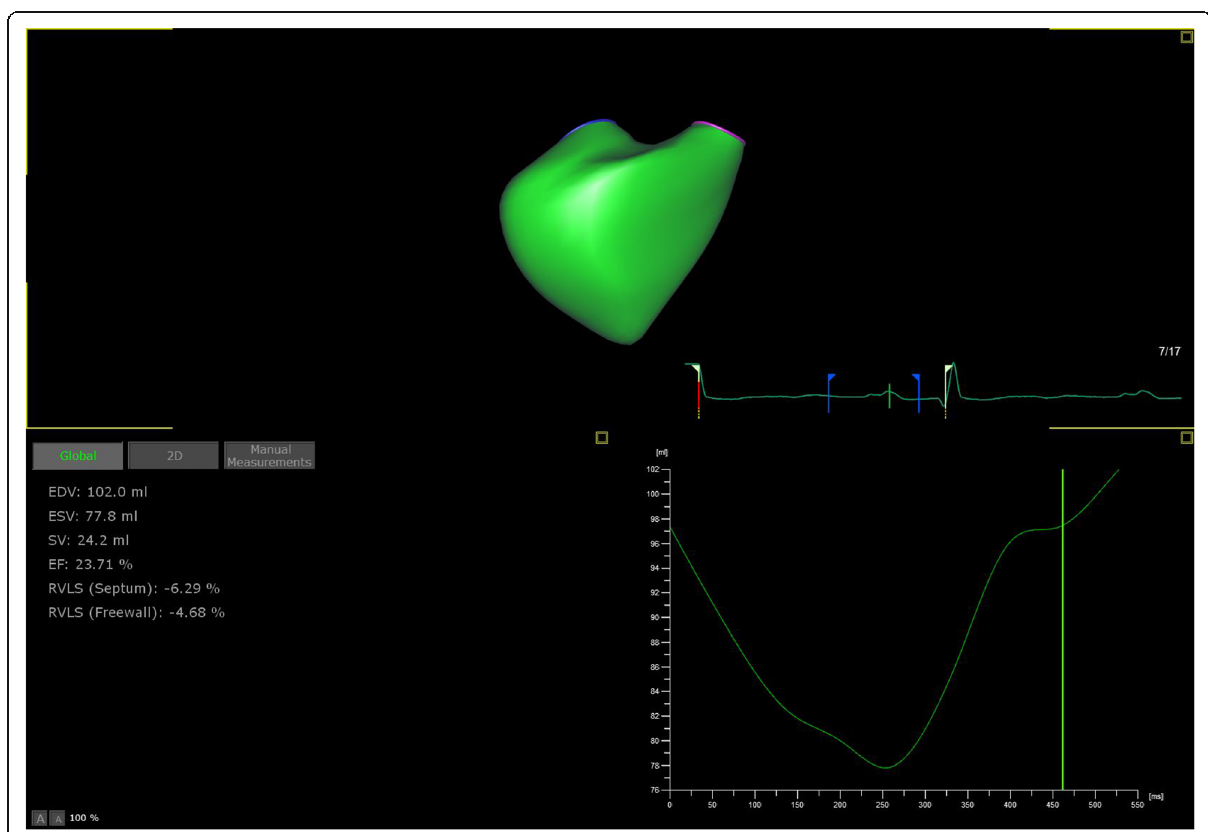
Fig. 1 Three-dimensional right ventricular ejection fraction on postoperative day 15. Measurements were performed using 4D RV-FUNCTION® (TomTec Imaging Systems), which yielded a result of